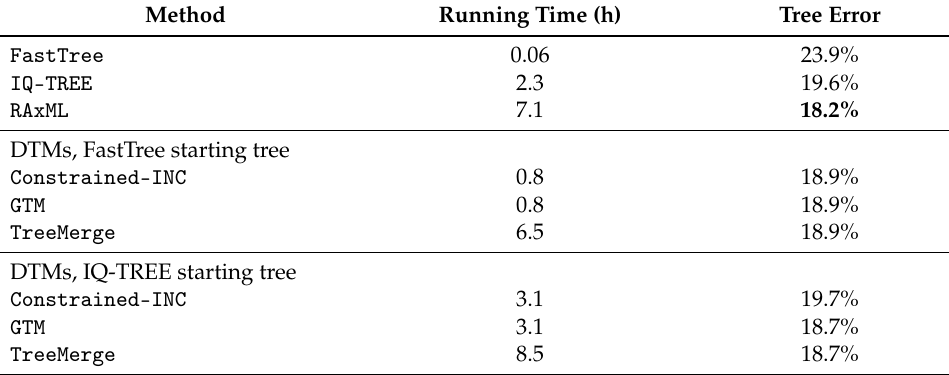
Table 4. Results on the Cox1-HET datasets. Tree error (FN) rates and running time for existing